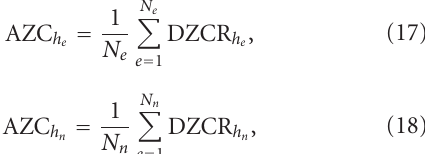
Figure 8: Disparity estimation approach. pair is restricted in horizontal direction only. The depth maps of the two sample stereo image pairs for block size 4 × 4, 8 × 8, and 16 × 16 with searching area ± 128 pixels are shown in Figure 9. Colors in the depth maps that are indicated by vertical color bars in right are estimated depths symmetric and asymmetric Cattle images are shown